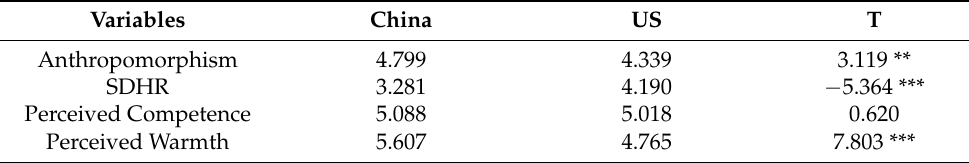
Table 9. Comparison of variable means for Chinese and American participants. Variables